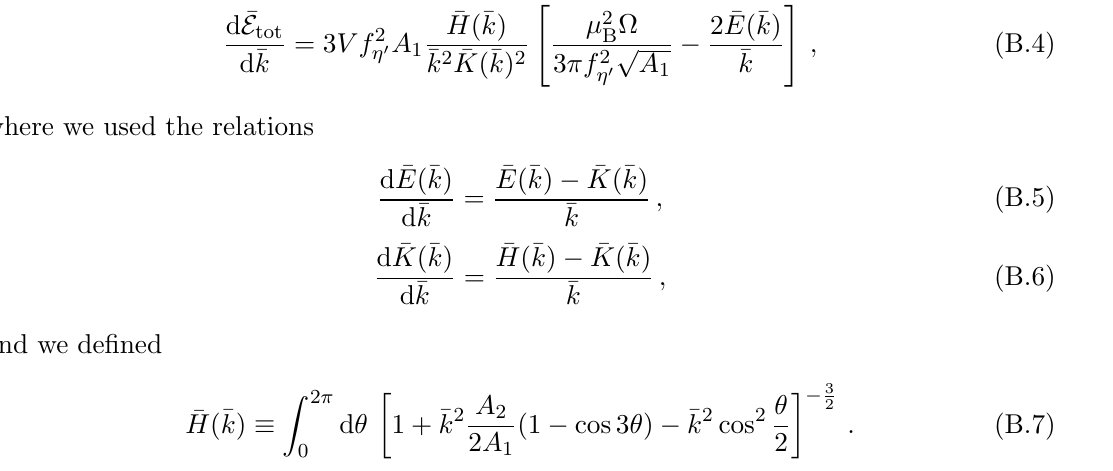
1) (cid:25)= 3 and (2 n + 1) (cid:25)= 3. (b) (cid:30) is (cid:0)